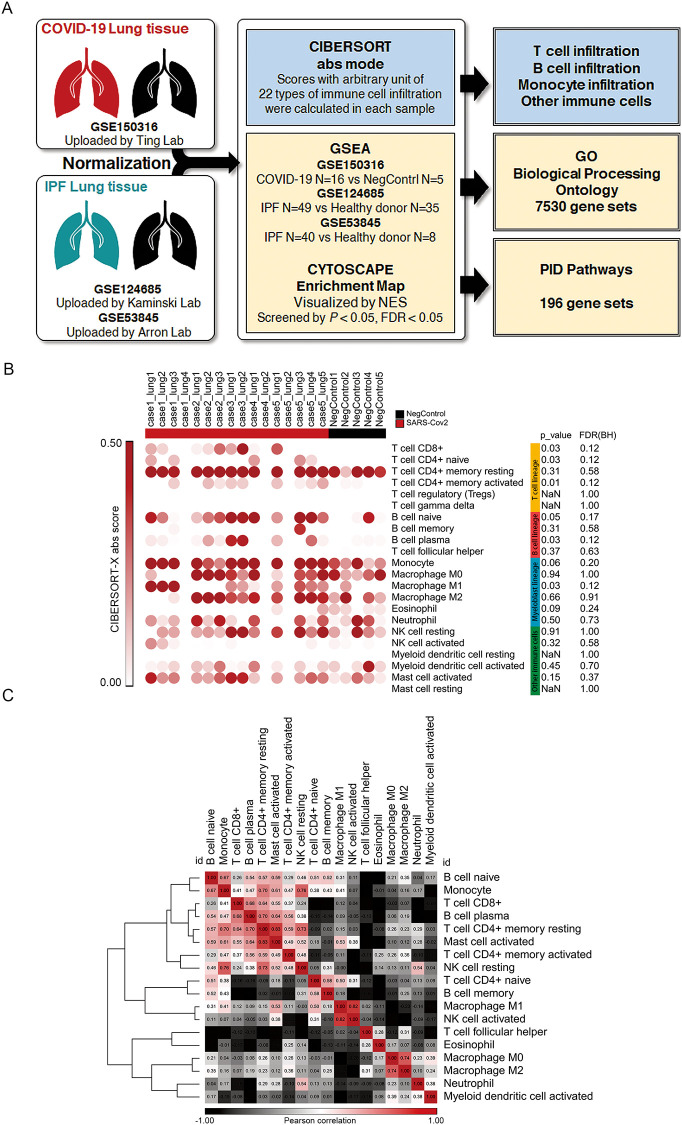
Overall procedure of the study and transcriptional estimated infiltration of 22 types of immune cells in the lungs of COVID-19 patients.(A) Diagram showing the comprehensive procedure of the study; (B) CIBERSORT abs score of 22 immune cells, colors represent the classification of the following: T cell lineage, B cell lineage, Myeloblast lineage, and other immune cells; (C) Similarity matrix representing the correlation among 22 immune cells in GSE150316.